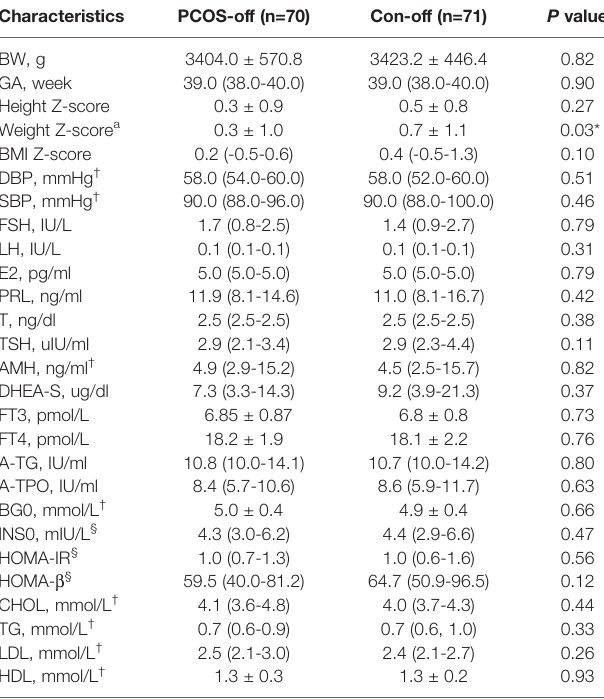
TABLE 1 | Baseline characteristics of the study population. Characteristics